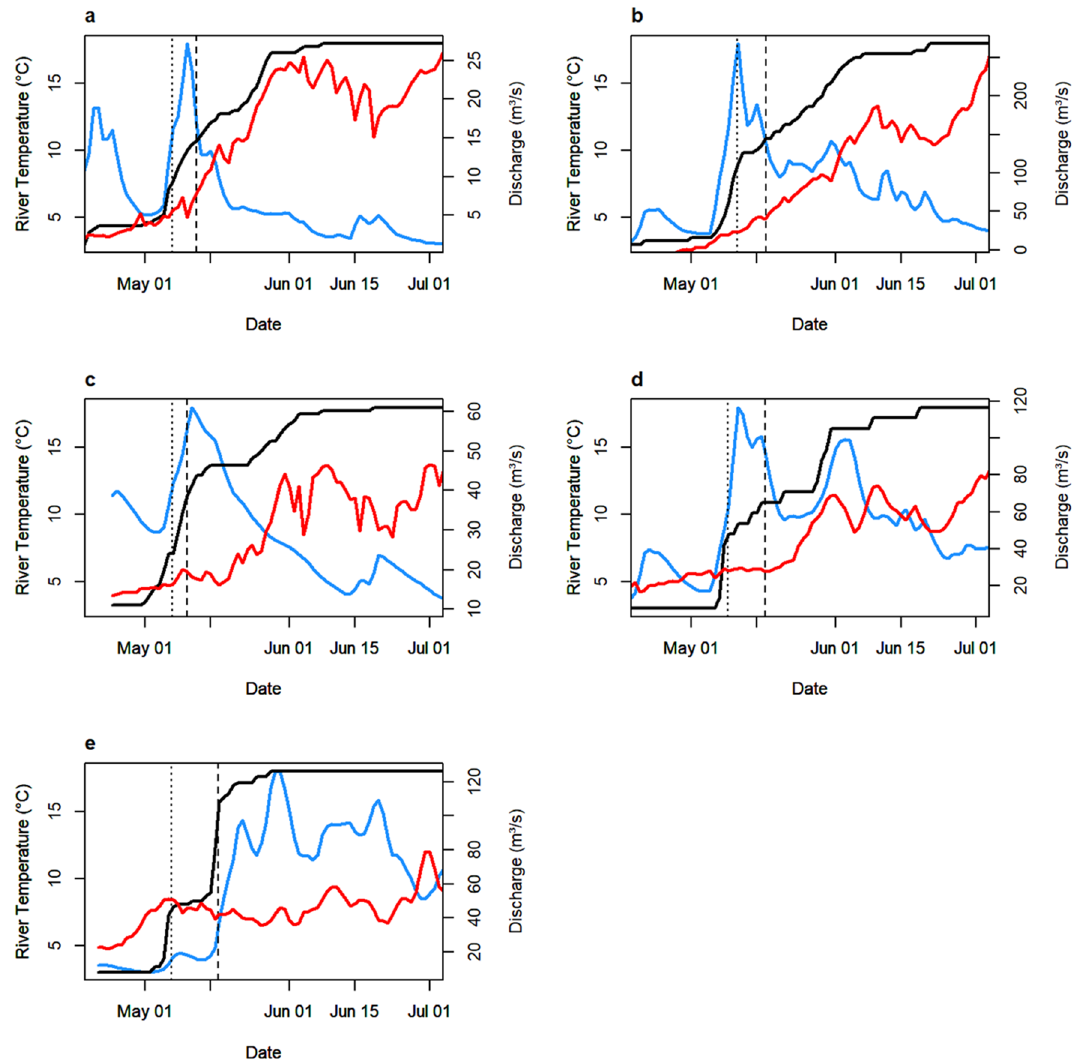
Figure 3. Mean daily water discharge (blue), mean daily temperature (red), and cumulative migration curve (black) through the migration period for ( a ) Granvin 2018, ( b ) Eio 2018, ( c ) Eid 2018, ( d ) Stryn 2018, and ( e ) Stryn 2017. 25% and 50% migration dates are shown as dotted and dashed lines,